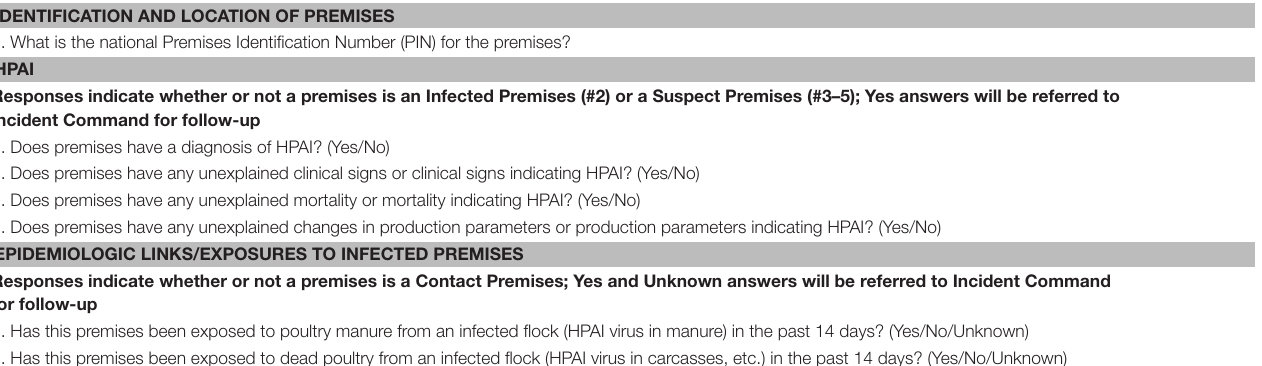
TABLE 1 | Questions included in the Minnesota Monitored Premises Status Questionnaire